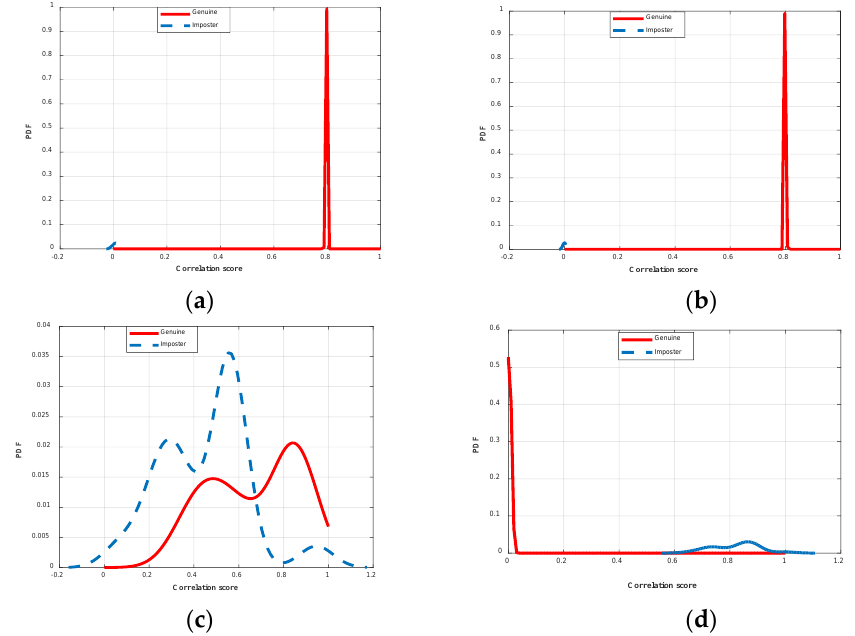
Figure 12. Probability distributions for cancellable face recognition frameworks (for ORL dataset) for ( a ) CFR1, ( b ) CFR2, ( c ) homomorphic transform followed by salting and ( d ) homomorphic transform followed by random kernel convolution.